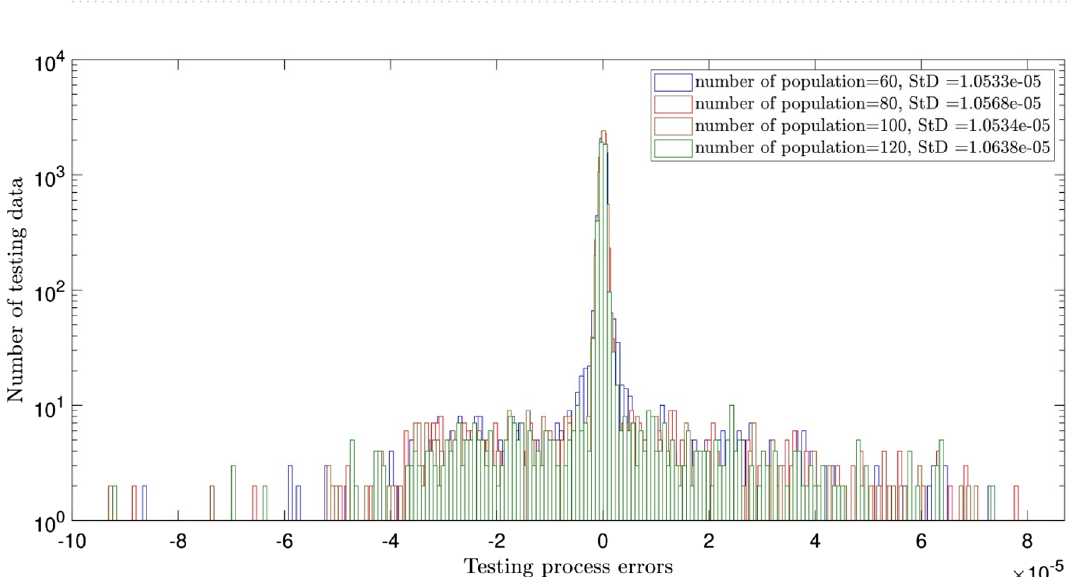
Figure 2. Standard deviation errors for different DEFIS learning processes considering different crossover with two inputs.